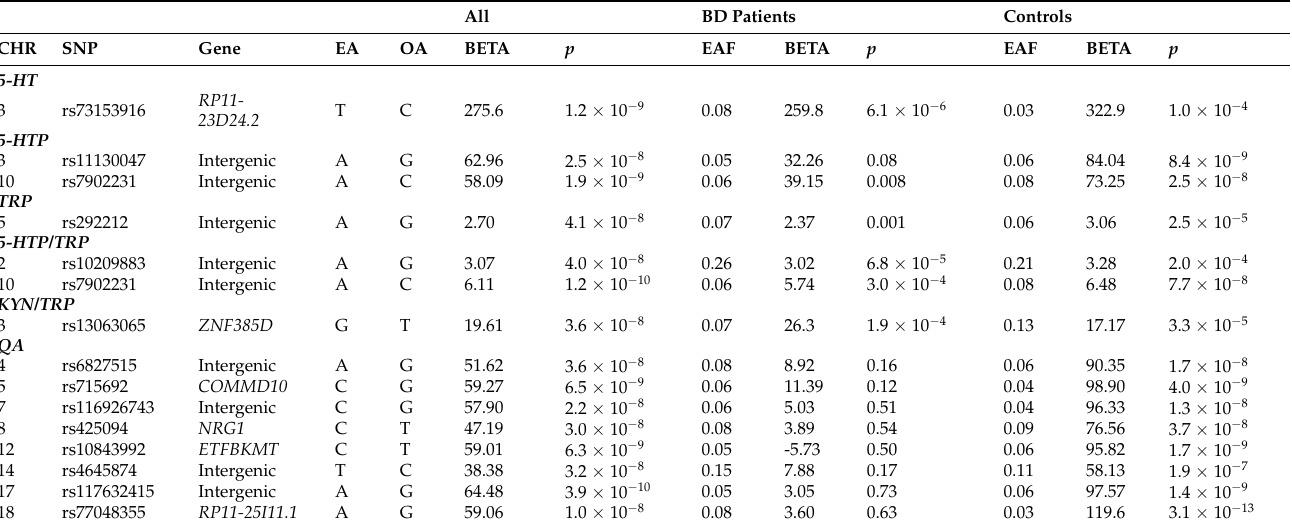
Table 2. SNPs significantly associated with metabolite levels, with a significant effect of diagnosis. All